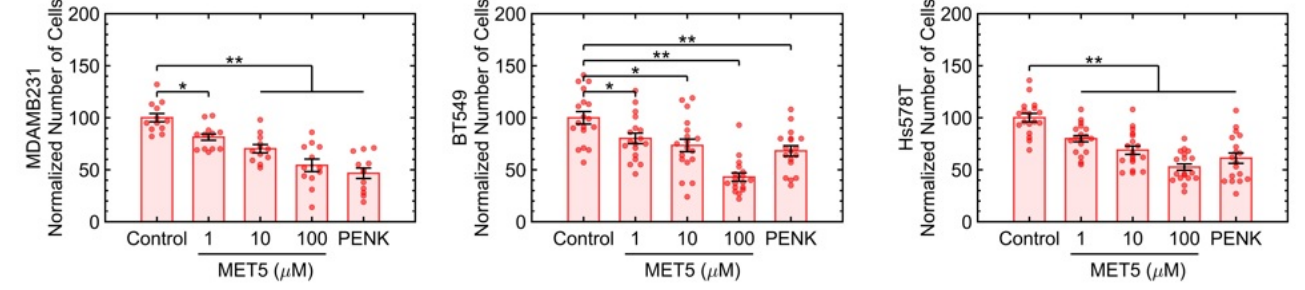
Figure 4. The agonist antibody for one of the PENK receptors, namely OGFr, induces growth suppression in all three TNBC cell lines. Each condition had six replicates with at least two fields of view per well imaged. * p -value<0.05 and ** p -value < 0.001.